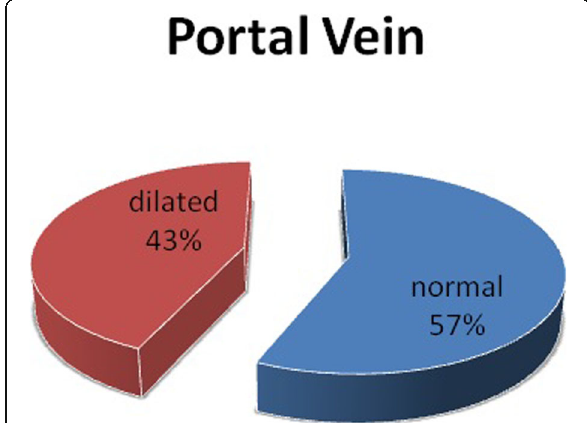
Fig. 3 A pie chart showing distribution of the studied patients regarding their portal vein